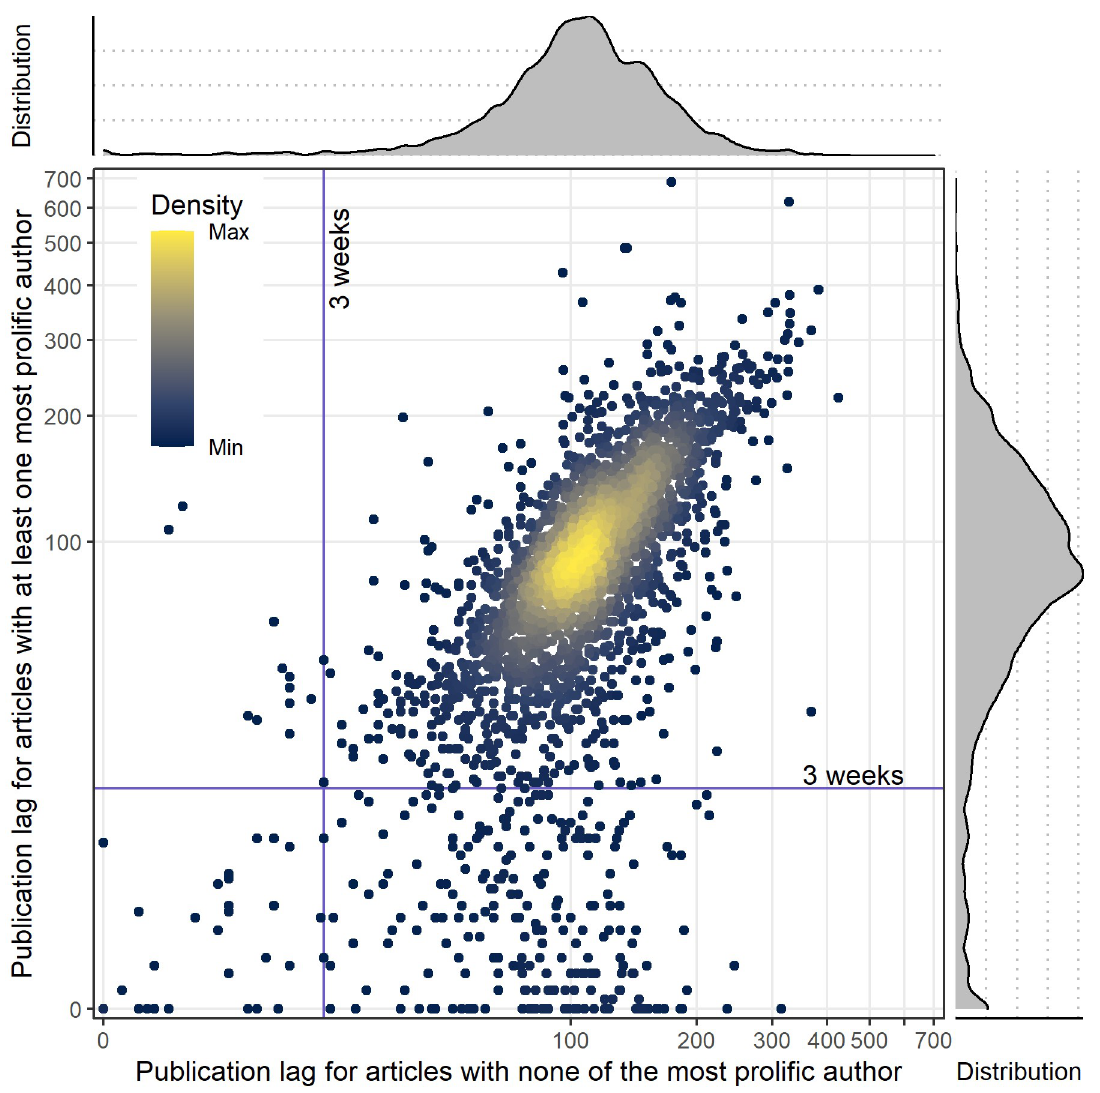
Fig 3. Publication lag. Distribution of the publication lag median for the subgroup of 2,725 (49.8%) journals reporting submission and publication dates. Publication lag median (in days) are presented for articles signed by the most prolific authors compared to the articles without any of the most prolific authors (with marginal density plot of distributions). The data underlying this figure may be found in